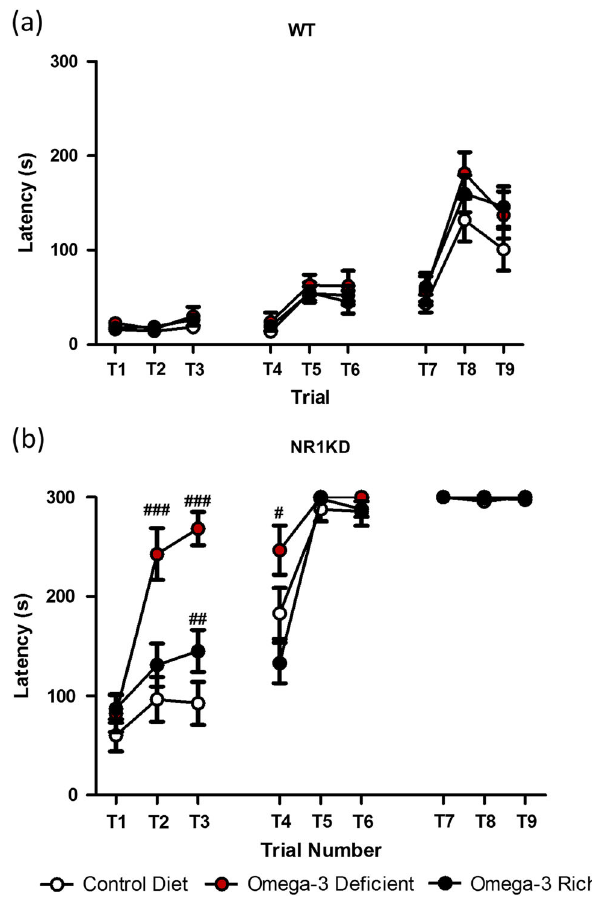
Fig. 3 Omega-3-de fi cient diet worsens executive function in NR1KD mice. Adult male and female mice aged 12 – 15 weeks were tested over 3 days for executive function using a goal-oriented puzzle box task. Executive function was measured by the latency to reach a goal box, with a 5 min time limit. Genotype differences were found in each trial between WT and NR1KD mice in the three diets ( p < 0.05). a No signi fi cant difference was observed in WT mice on the different diets. b NR1KD mice on the omega-3-de fi cient diet required more time to perform tasks on trials T2-T4 compared to the control diet ( p < 0.05 – 0.001). Diet-genotype interaction at T2-T4: p ≤ 0.001. All statistics performed using repeated measures ANOVA, Bonferroni post-hoc. Data shown as mean ± SEM. # p < 0.05, ## p < 0.01, ### p < 0.001 for within genotype, across diet comparison. Control diet ( n = ): WT 8M, 15F; NR1 6M, 7F. De fi cient diet ( n = ): WT 15M, 15F; NR1 7M, 13F. Supplemented diet ( n = ): WT 13M, 19F; NR1 13M,